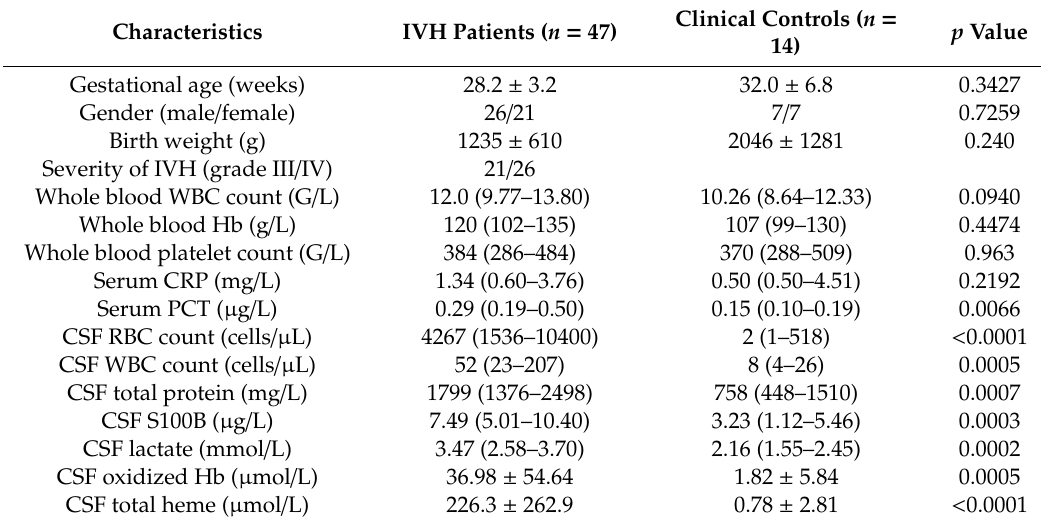
Table 1. Baseline demographical and laboratory parameters of preterm IVH and control patients (n indicates the number of involved patients). Data are expressed in mean ± SD or median with (interquartile range) as appropriate. For statistical analysis, chi-square test and unpaired t-test or Mann–Whitney U test were used as